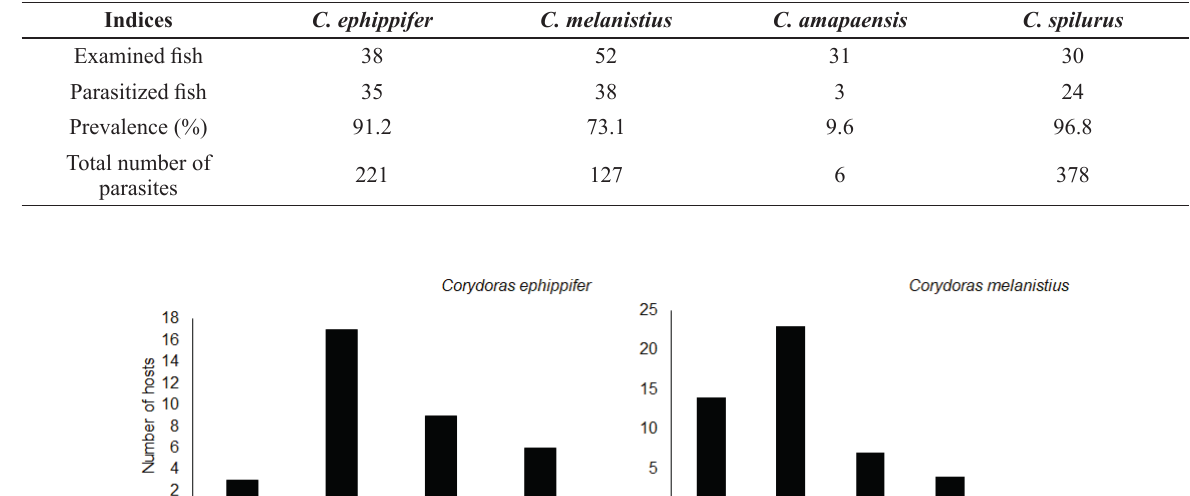
Total parasitological indices in four species of Corydoras endemic to the eastern Amazon (Brazil).